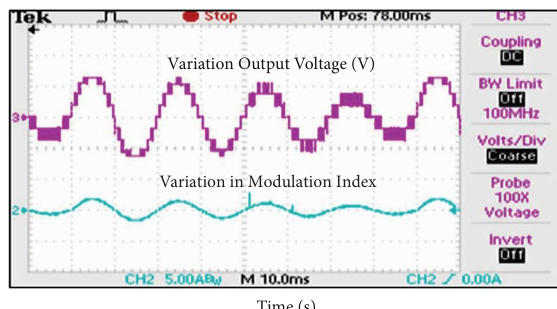
Figure 22: Variation of output voltage with change in modulation